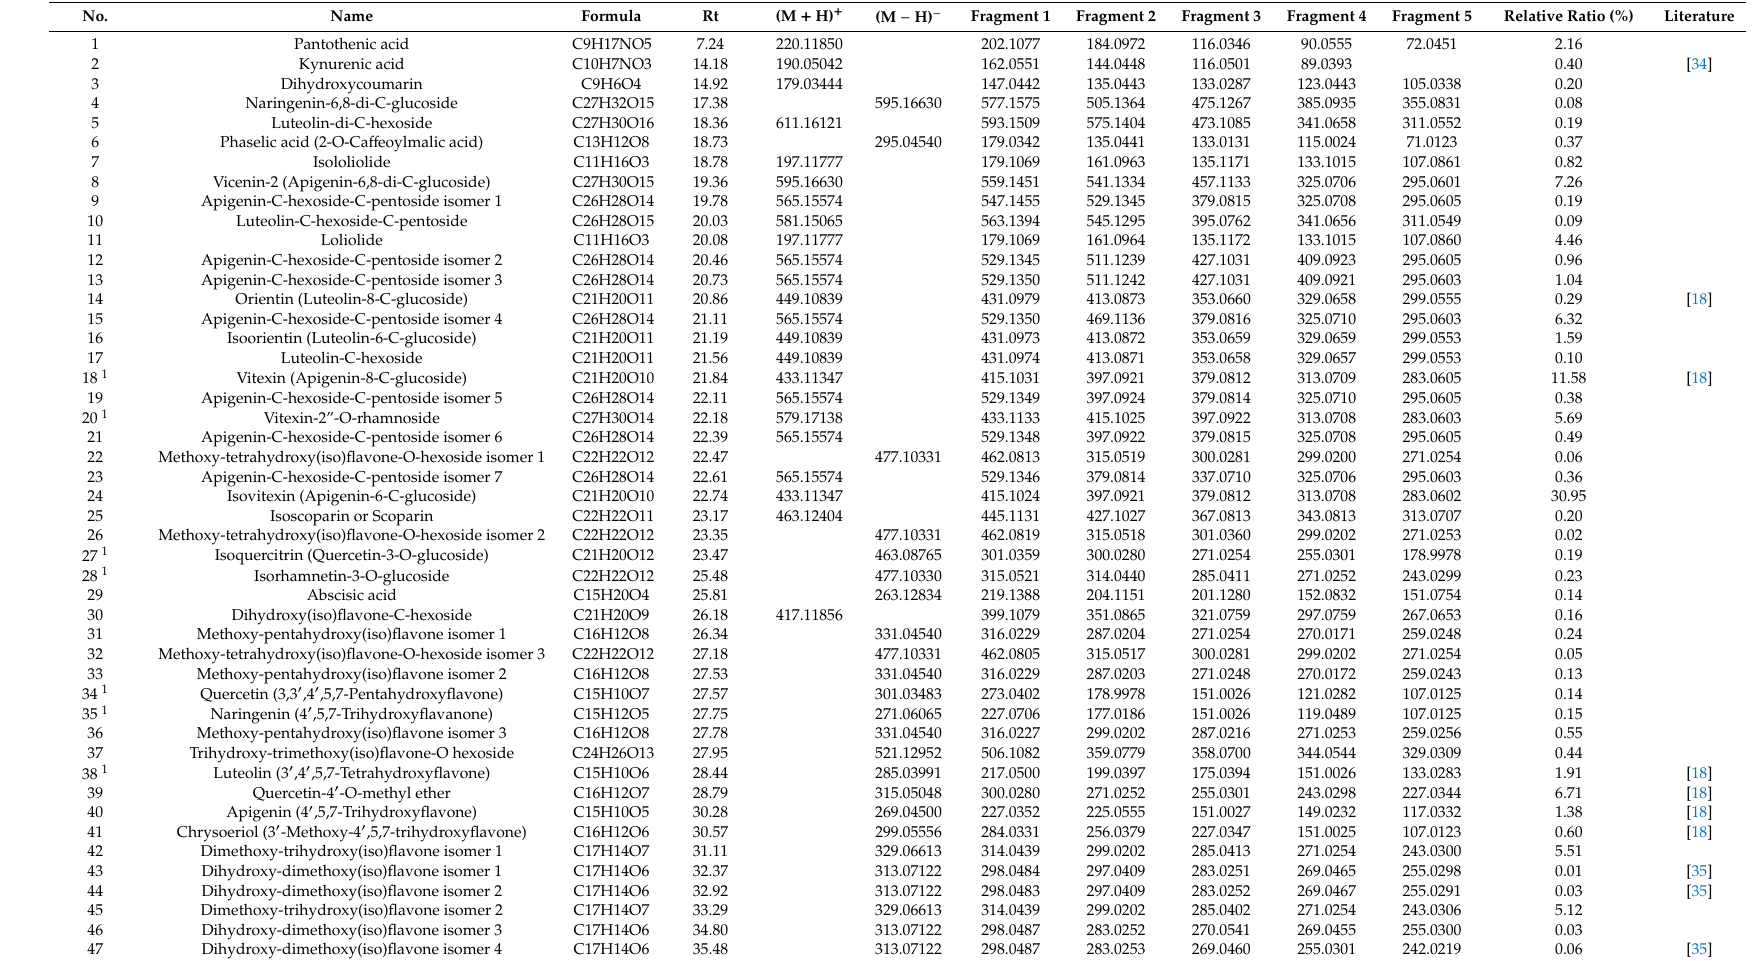
Table 2. Chemical profile of infusion